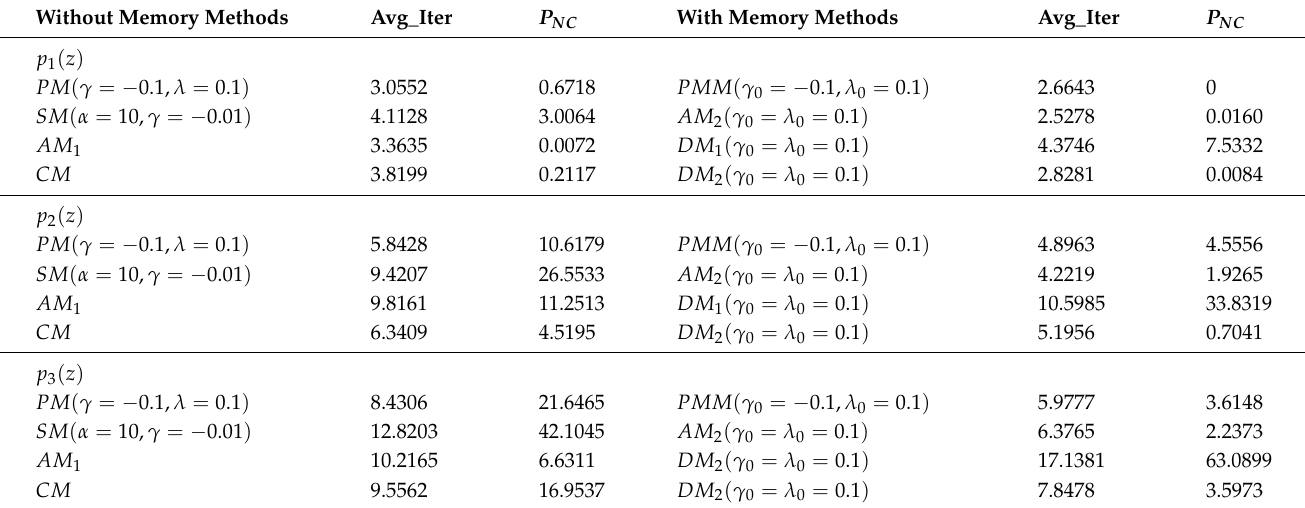
Table 6. Comparison of the different methods without and with memory in terms of Avg_Iter and P NC